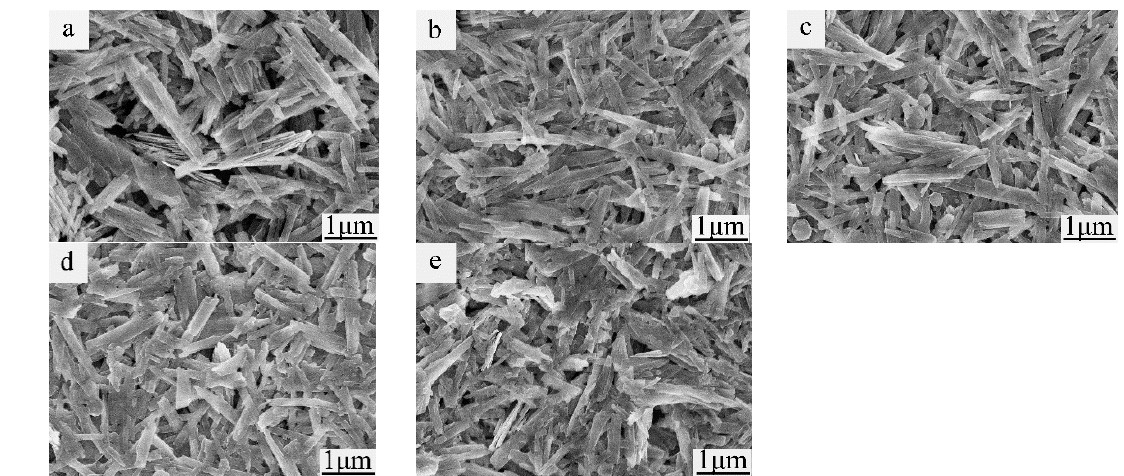
Figure 2. SEM images of ( a ) Ni 0 , ( b ) Ni 1 , ( c ) Ni 2 , ( d ) Ni 3 , and ( e ) Ni 4 , respectively.